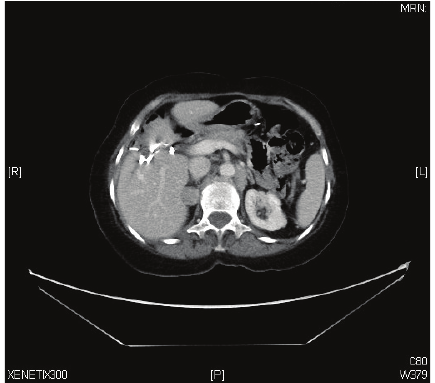
Figure 4: Follow-up abdominal CT at one year showing the recurrent soft tissue mass adjacent to the liver inseparable from the right adrenal and interval increased in size of the left para-aortic lymph